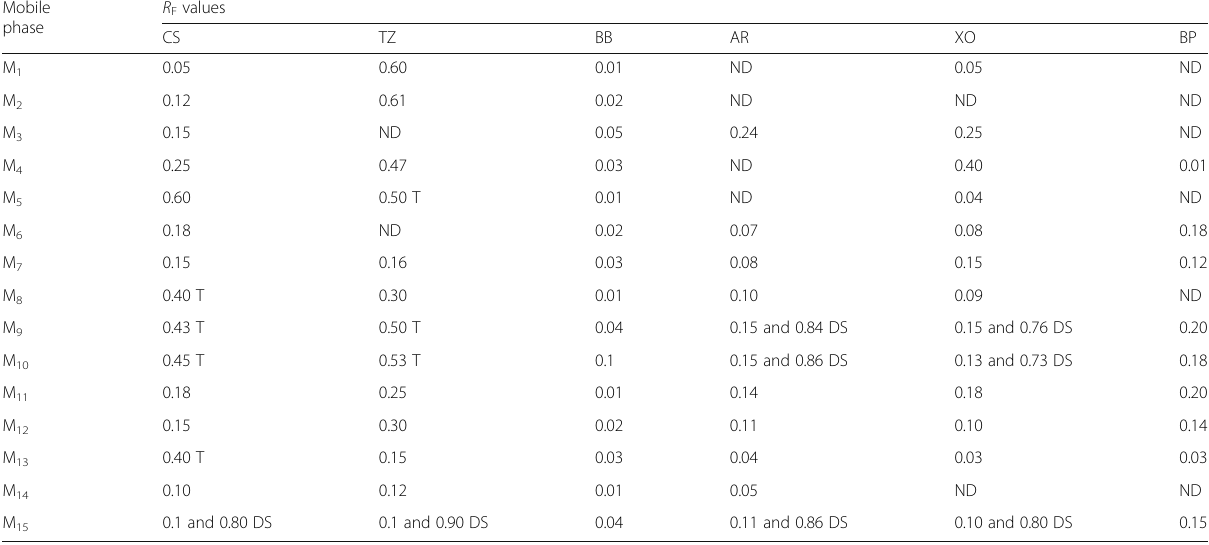
Table 5 Mobility of dyes in terms of R F values on stationary phase S 3 with different mobile phases Mobile phase